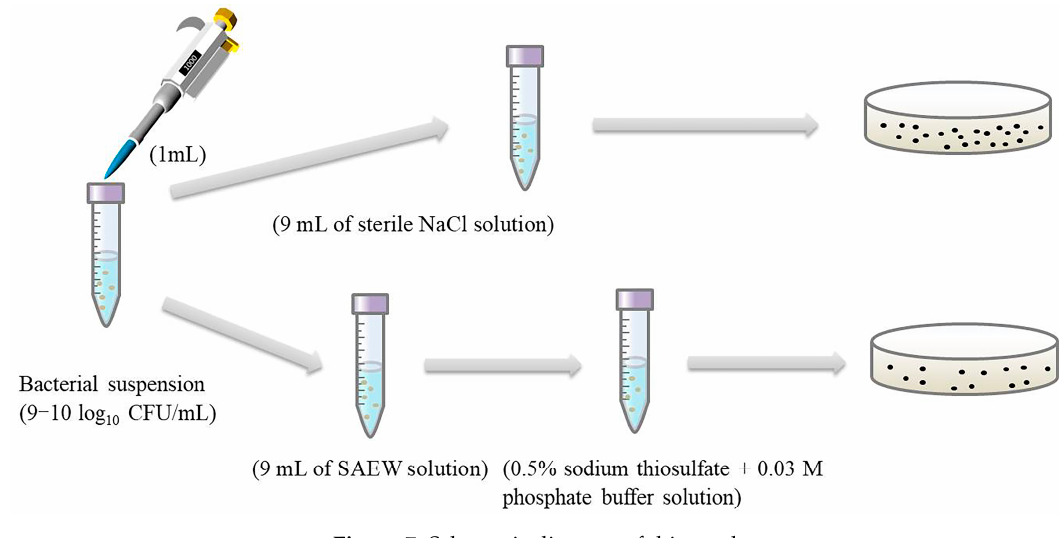
Figure 7. Schematic diagram of this work.